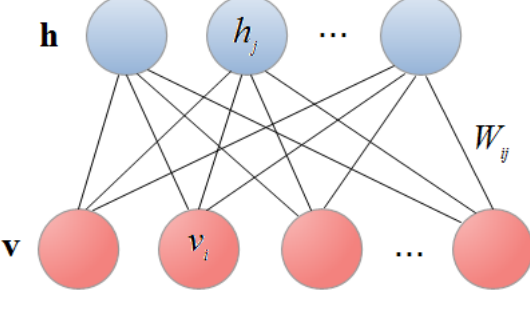
Figure 2. Restricted Boltzmann